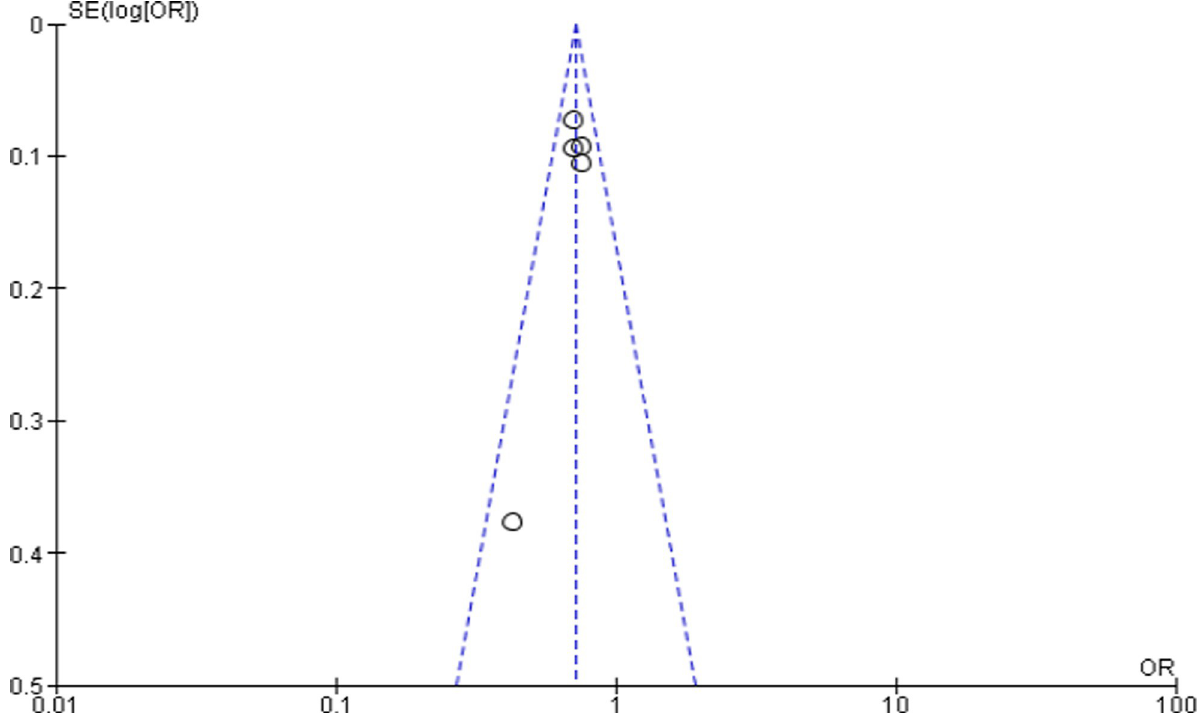
Fig 3. Funnel plot of five studies to show the effect of primary maternal education on infant mortality in Ethiopia.